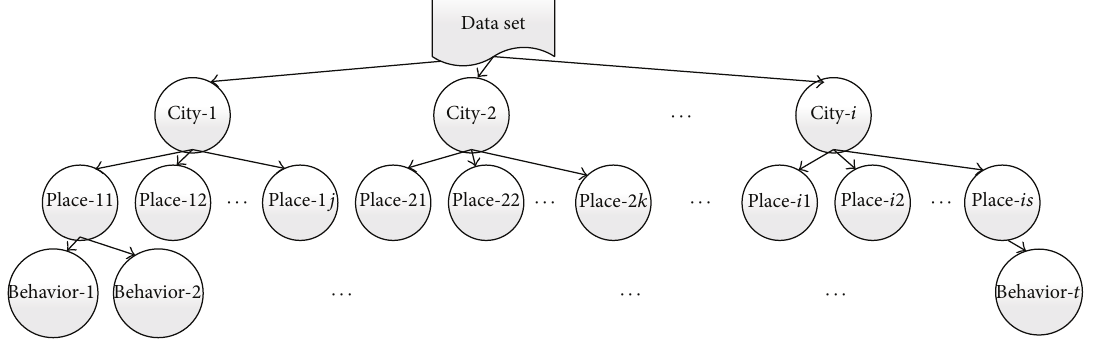
Figure 2: Classification